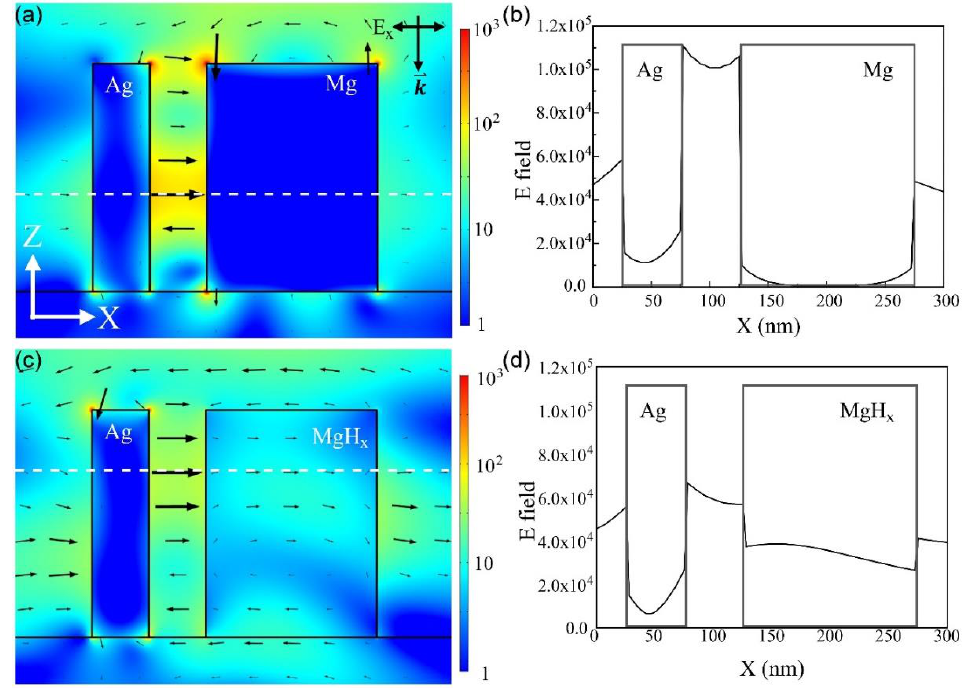
Figure 4. Electric (E) field intensity profiles of sensor composed of Ag and Mg nano-blocks for incident light with 400 nm wavelength: ( a ) before and ( c ) after absorbing hydrogen. ( b,d ) E field intensity along x-direction (white-dotted lines in ( a,c ) represent the z-point of maximal intensity in the gap mode between Ag and Mg blocks).